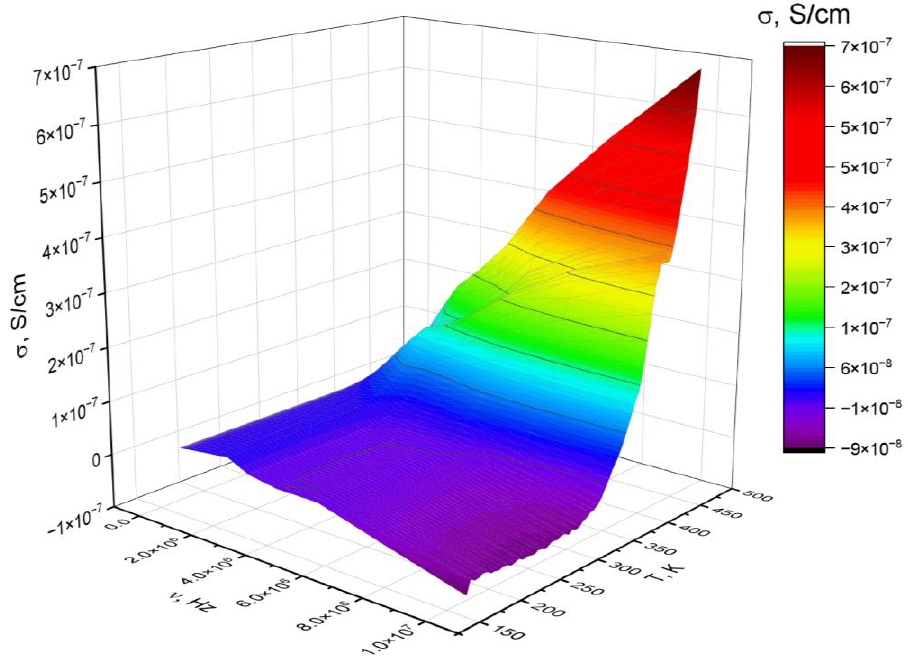
Figure 9. The temperature dependences of conductivity for polyNBi at different frequencies.